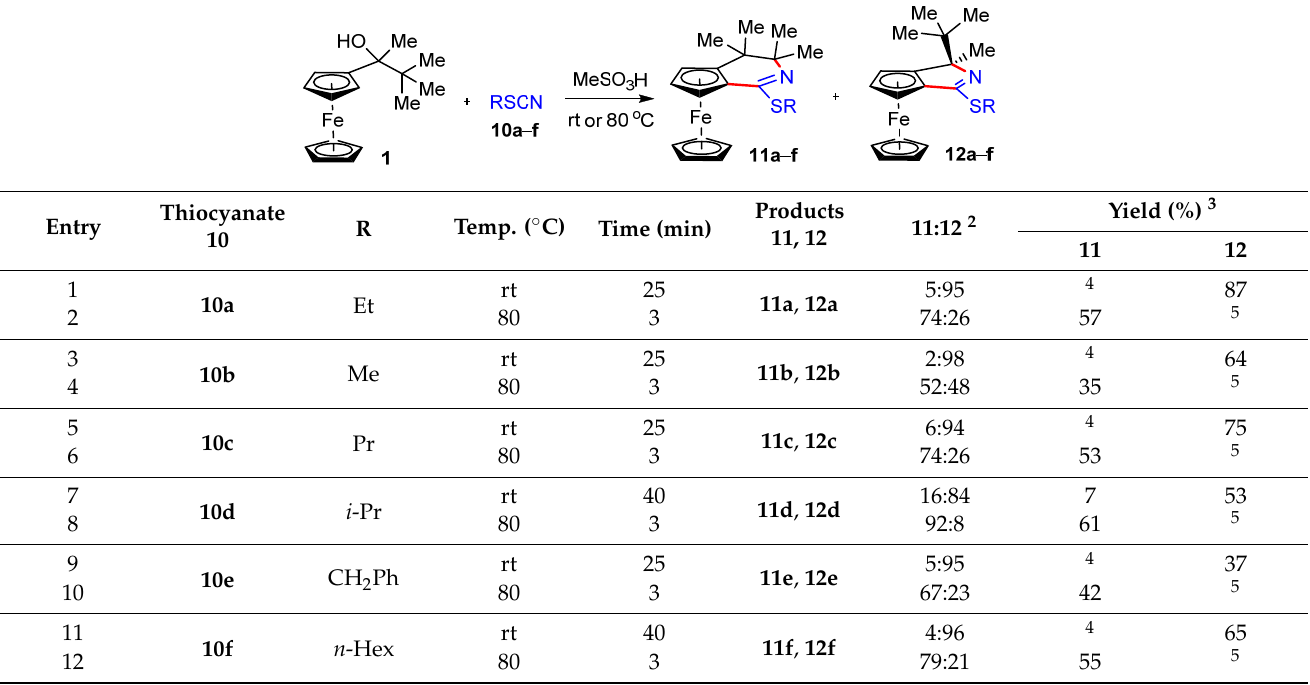
Table 5. Reaction of alcohol 1 with thiocyanates 10a – f 1 .